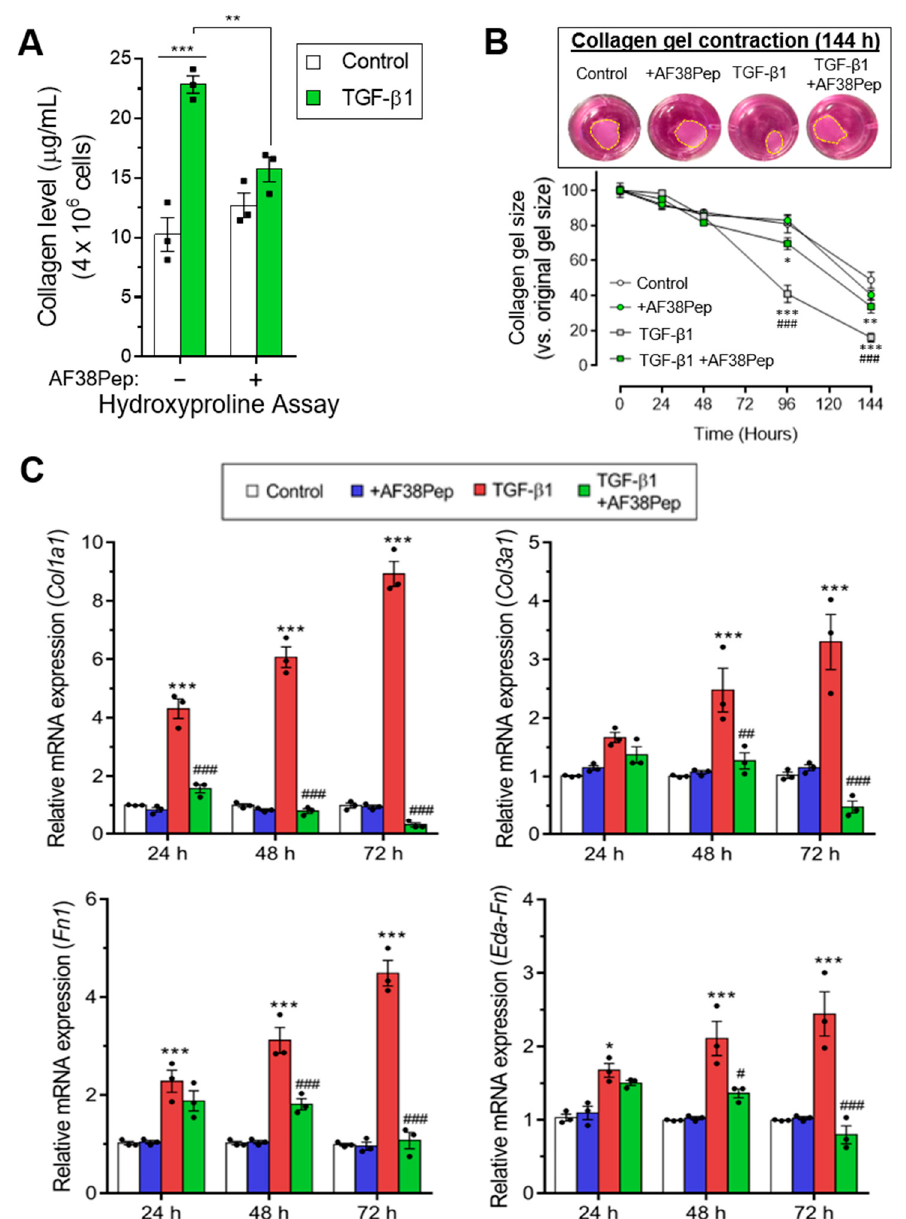
Figure 10. Assessment of blocking peptide effect on profibrotic activity and integrin α 4 β 1-induced gene expression. ( A ) The quantification of total collagen production by NIH/3T3 cells as calculated from hydroxyproline assays after 48 h of treatment time. ( B ) Collagen gel contraction assay over the course of 144 h in the absence or presence of the small blocking peptide and 10 ng/mL TGF- β 1. The contracted collagen gel images are shown at the 144 h timepoint. Yellow dashed lines show perimeters of contracted gels. The mRNA expression for ( C ) fibrosis-associated genes: Col1a1 , Col3a1 , Fn1, and Eda-Fn1 were assessed by qRT-PCR at 24, 48 and 72 h. Data are representative of three independent experiments and shown as the mean ± S.E. Statistical analysis is shown as *** p ≤ 0.001, ** p ≤ 0.01, and ns = no statistical significance ( p > 0.05). #, ##, ###—statistically significant difference in comparison to TGF- β 1-only stimulated